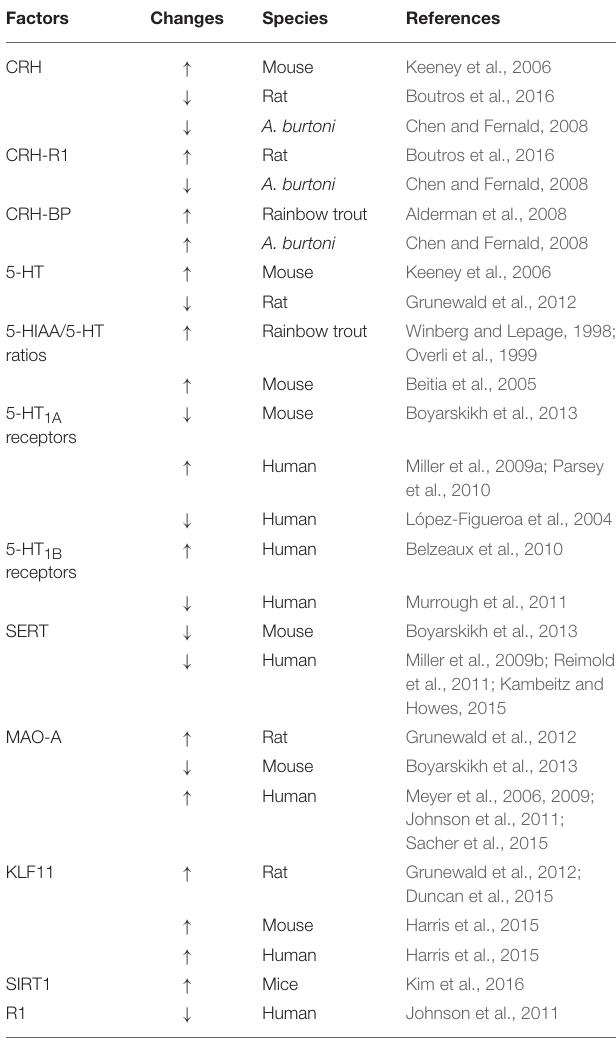
TABLE 1 | Factors changed by social stress in animal models or depression in